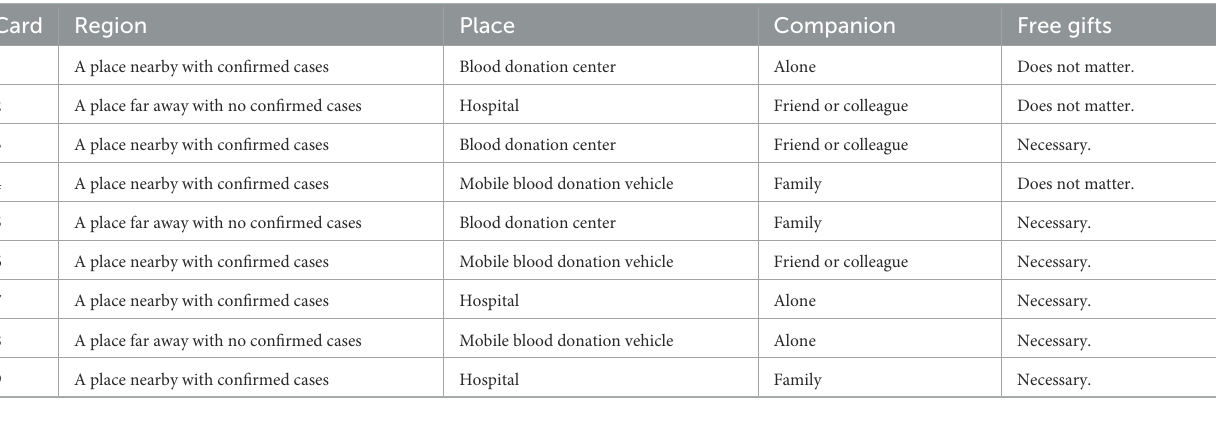
TABLE 6 Conjoint analysis results for the blood donation